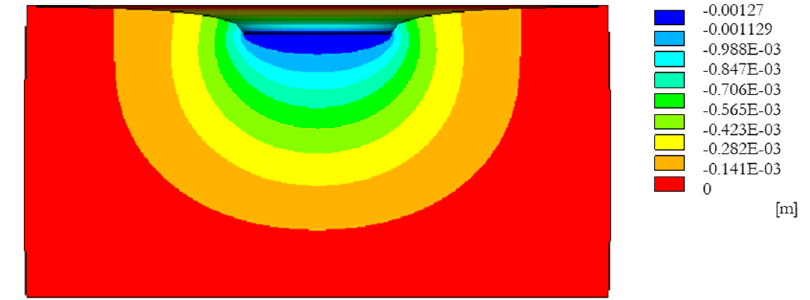
Figure 15. Vertical deformations, expressed in meters, employed to adjust the modulus of elasticity and the subgrade reaction